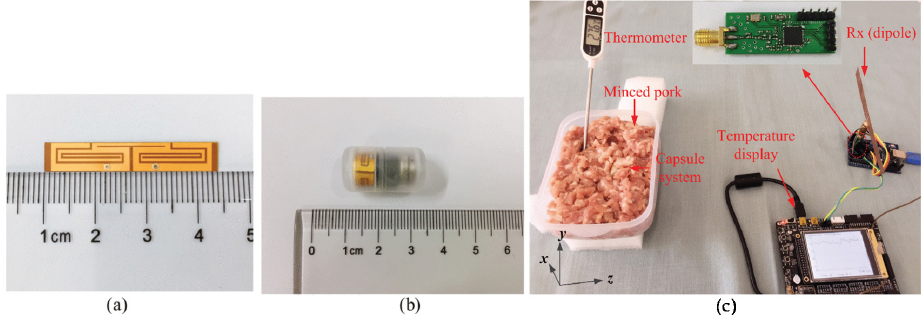
Figure 15. Prototypes of antenna for biomedical applications. ( a ) Proposed antenna, ( b ) integrated capsule system, and ( c ) measurement setup of communication system [227].